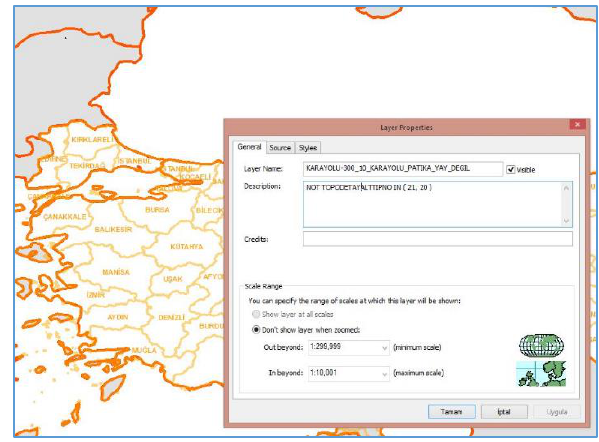
Figure 1. Layers and properties of WMS service